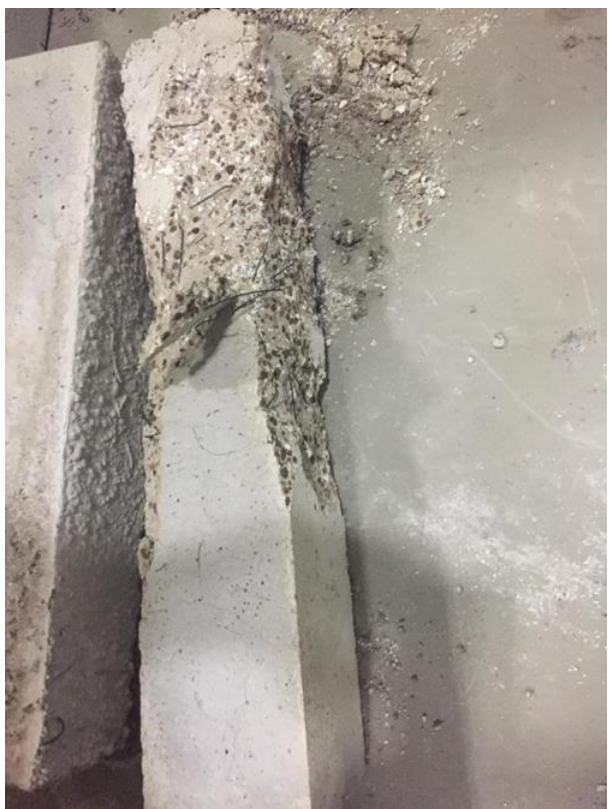
Figure 12. Deteriorated surface of 500 °C sample after water cooling.